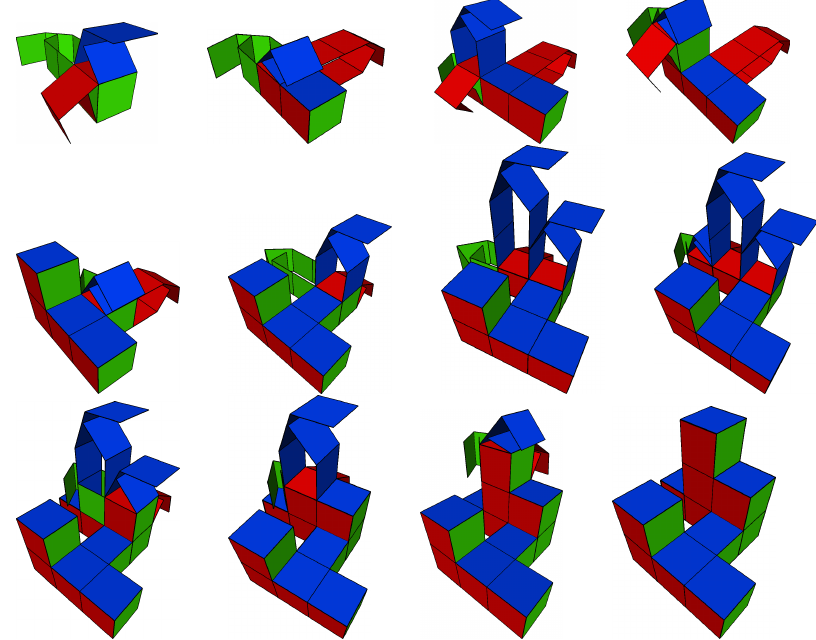
Figure 7. The construction of the polycube in Figure